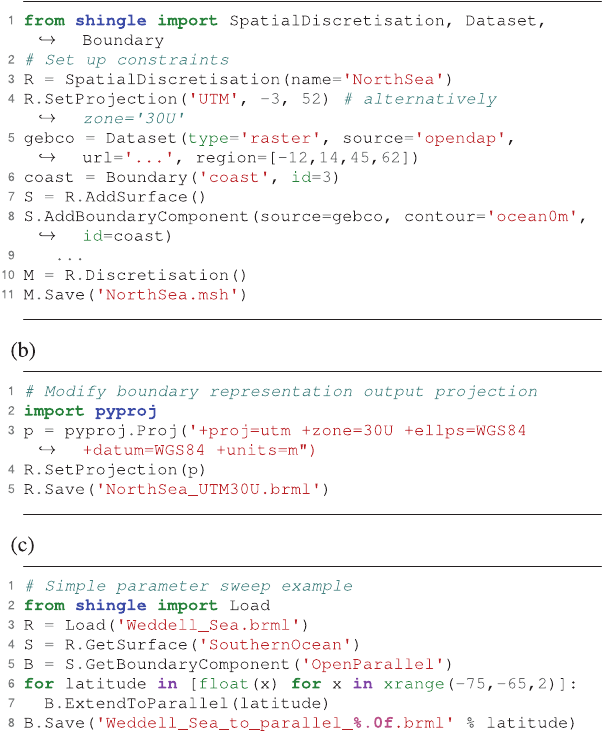
Figure 6. Example interactions with Shingle Python library Lib- Shingle. (a) Using natural language constructs native to Shingle, counterparts to BRML entries. (b) Together with objects native to external libraries. (c) Loading, extending, and saving descriptions from